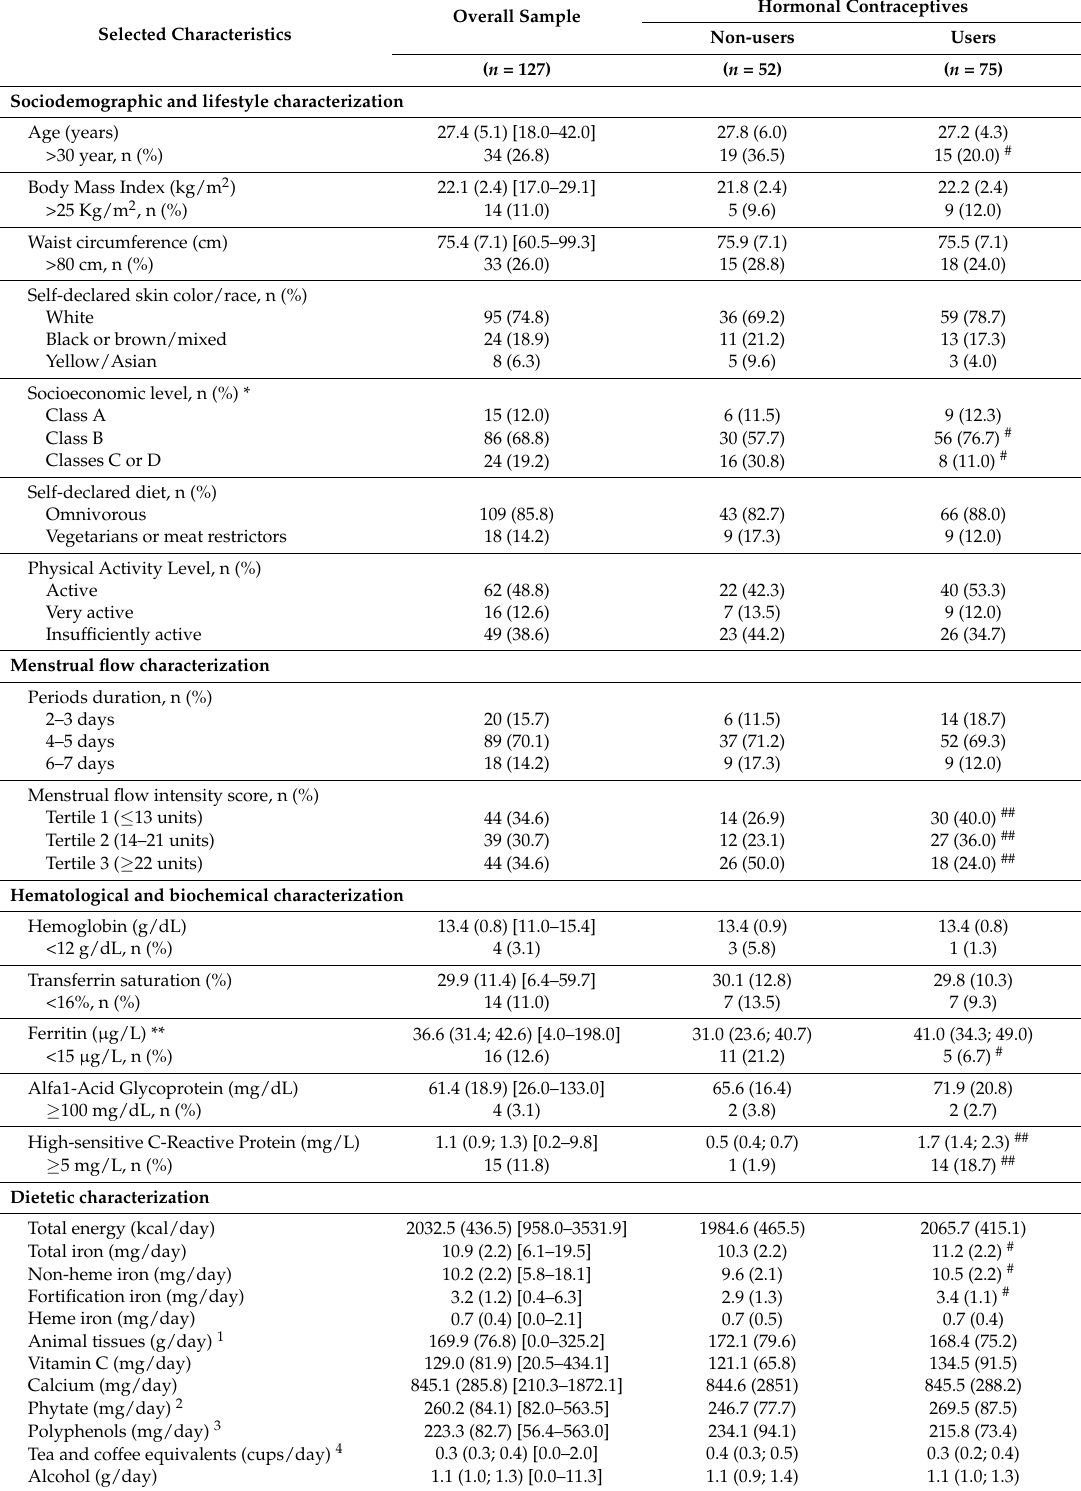
Table 2. General characterization of women at presumably steady-state body iron